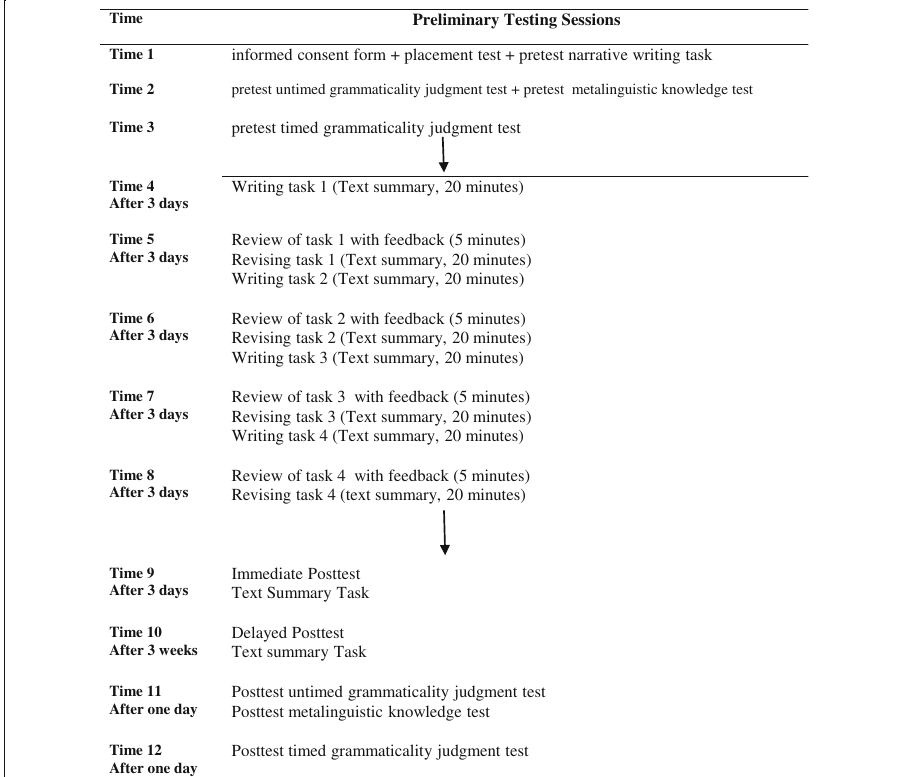
Fig. 2 Design and timeline of the first phase of study